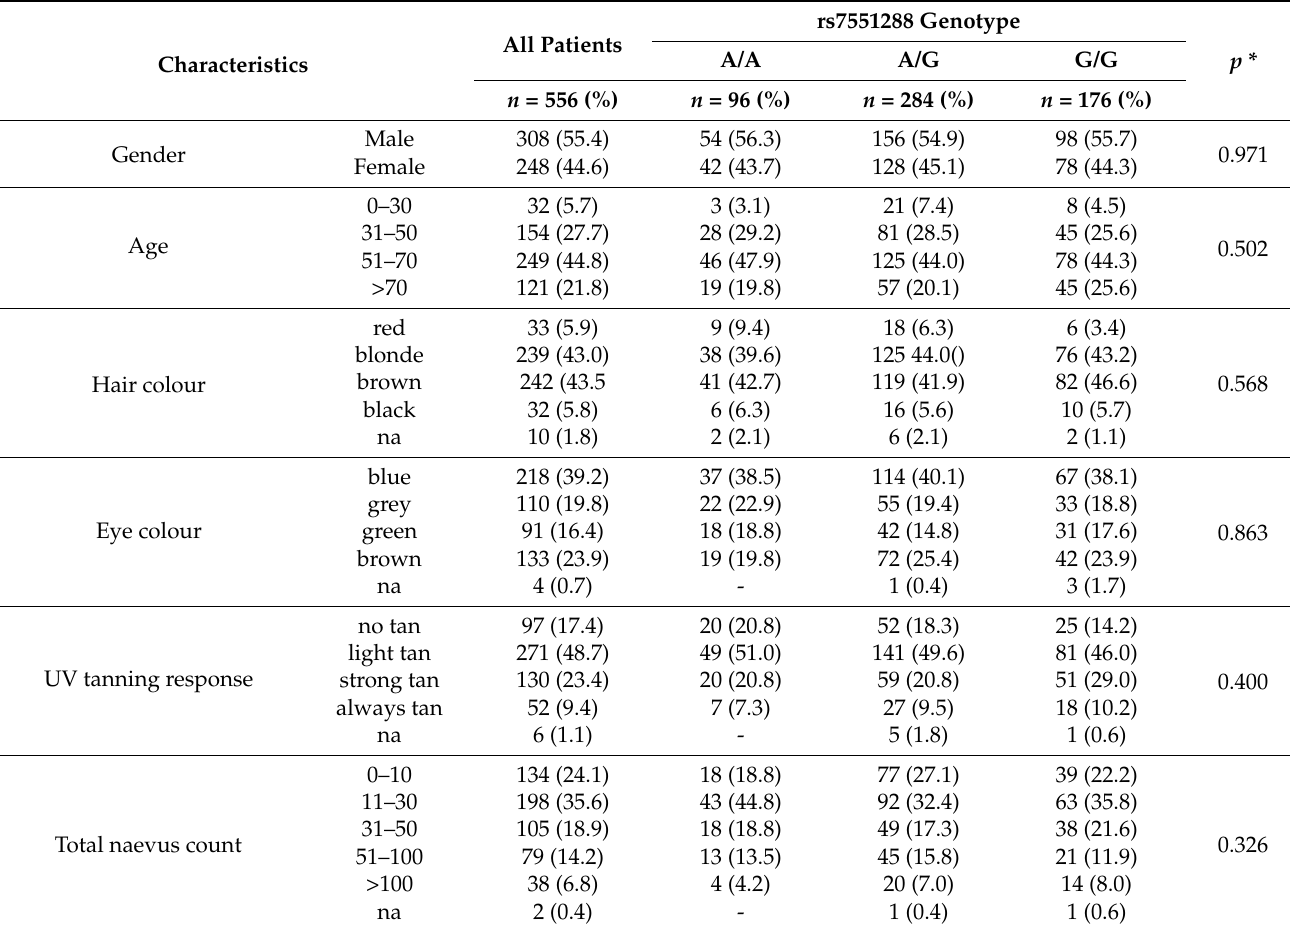
Figure 3. Details of the 92 patients who entered stage IV disease: ( a ) percentage of patients with positive, negative or unknown BRAF status; ( b ) percentage of patients receiving chemotherapy, BRAF inhibitor treatment*, immunotherapy** and systemic treatment within a clinical trial in stage IV. The share of the different genotypes is presented in green G/G, red A/G and blue A/A. * the unselective inhibitor Sorafenib was not considered as BRAF inhibitor treatment. ** this included RNA vaccination, L19-IL2 treatment, anti CTLA4 and PD1 antibodies. Table 1. Patients characteristics and rs7551288 genotype.